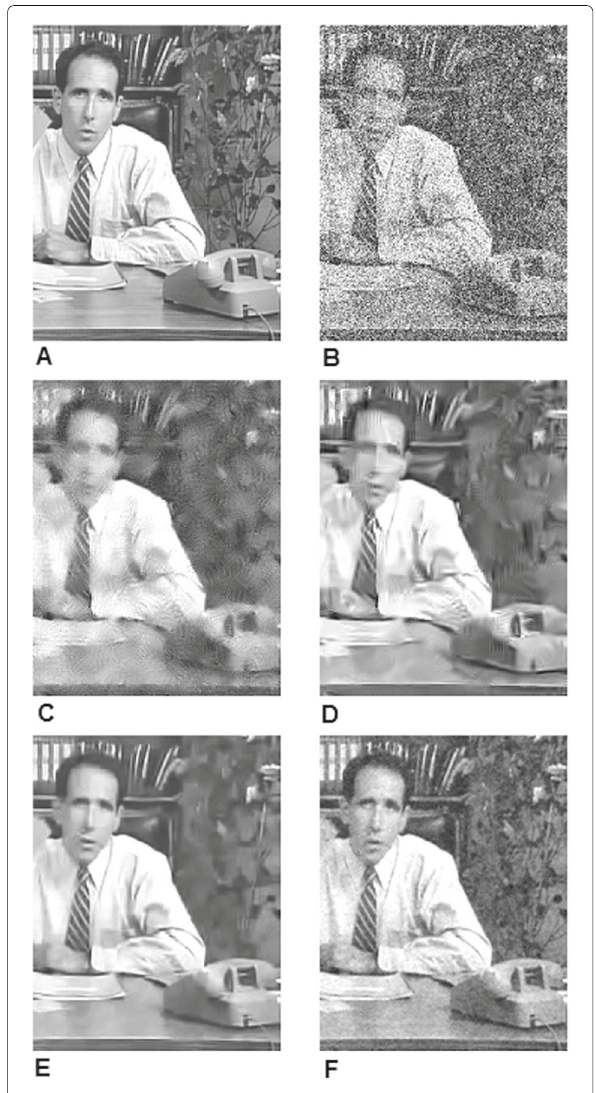
Fig. 4 Comparison of denoised frame 92 from the Salesman sequence with σ n = 40. a Original frame. b Corrupted frame. c SNLM. d BM3D. e VBM3D. f RNLM (BMA). The RNLM method appears to preserve the background details better than the other